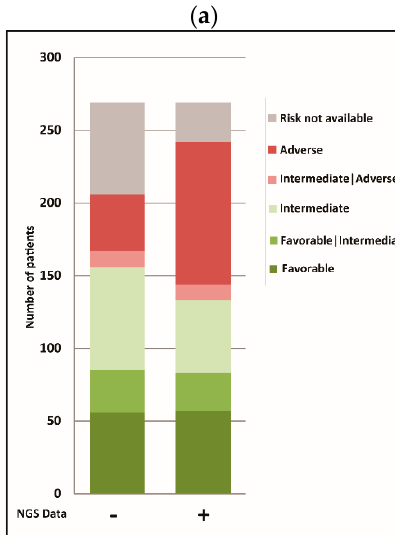
Figure 5. Extended mutation profiling improves risk stratification. ( a ) Risk stratification of patients was performed according to the ELN-2017 criteria, before ( − ) and after (+) incorporating the extended mutation profiling data obtained by high-throughput sequencing (NGS). Due to the lack of information on the FLT3 -ITD allelic burden, two additional groups were considered: favorable|intermediate and intermediate|adverse. ( b ) Kaplan–Meier curves for the overall survival of patients classified as adverse risk irrespective of data obtained by high-throughput sequencing (NGS no), and patients reclassified as adverse risk because high-throughput sequencing identified mutations in the ASXL1 , RUNX1 , and TP53 genes (NGS yes).